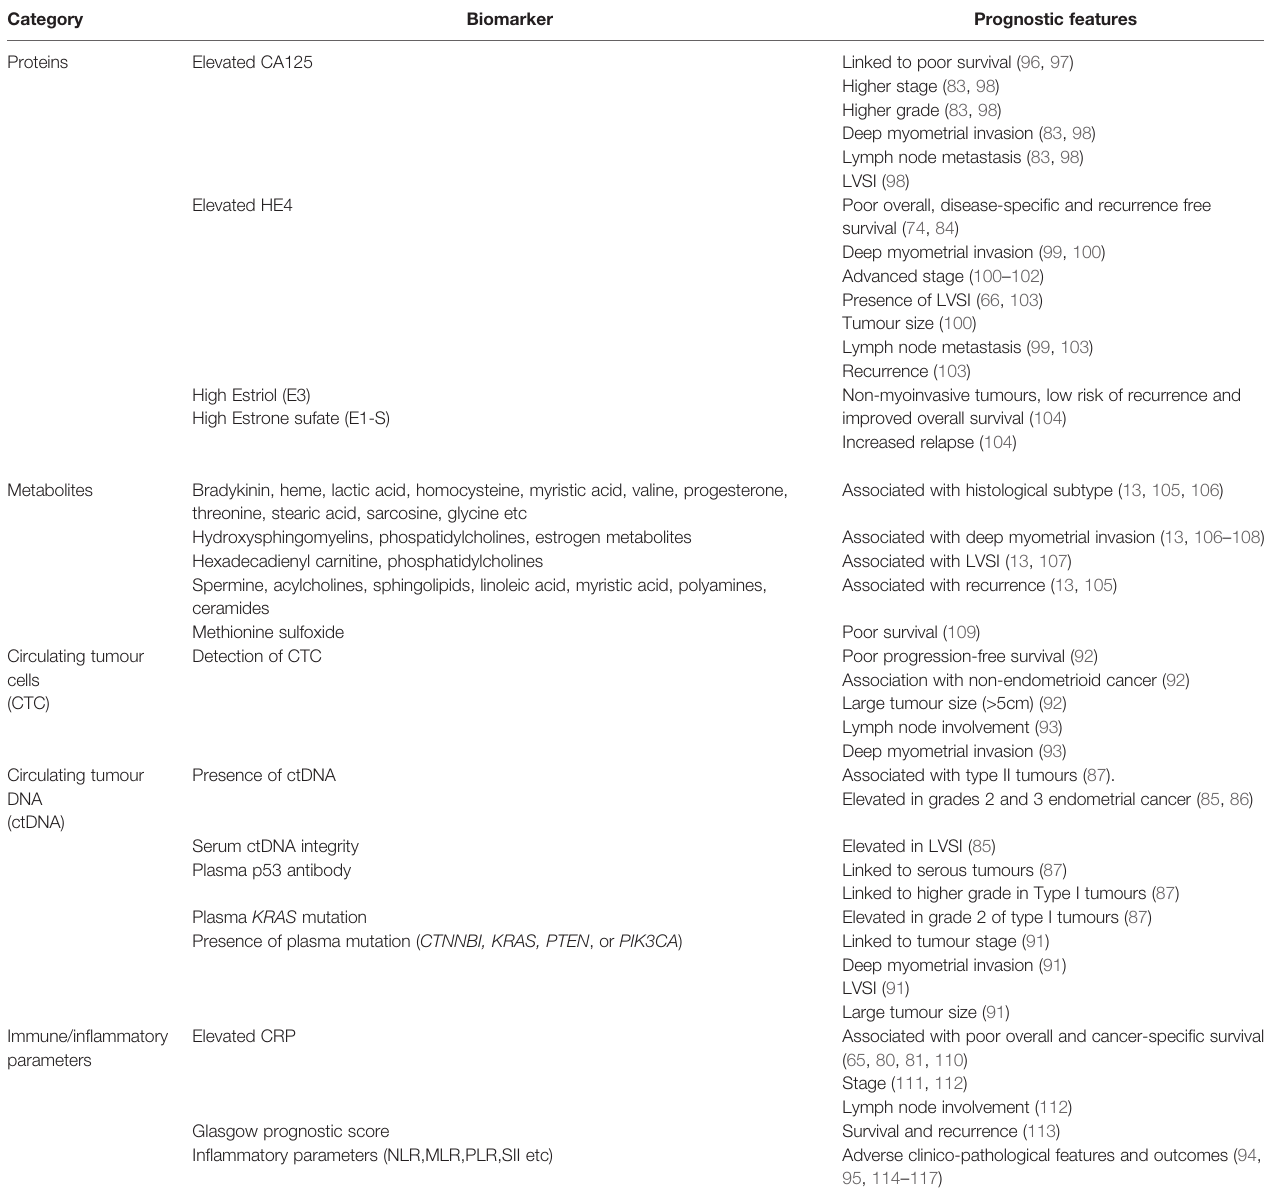
TABLE 5 | Circulating endometrial cancer prognostic